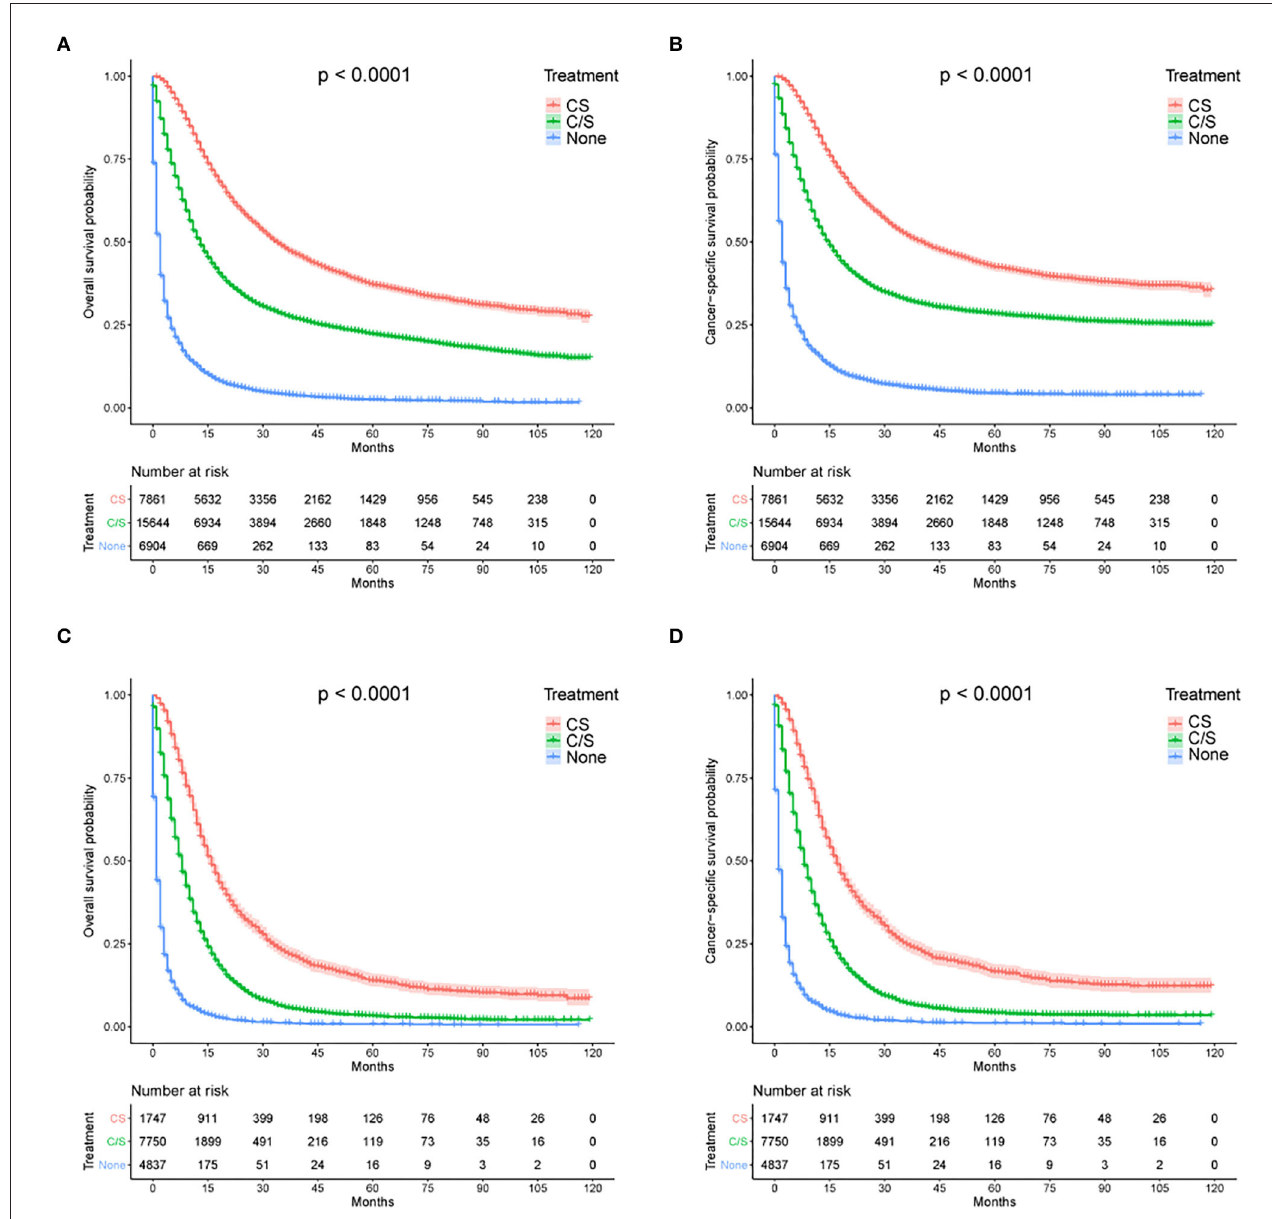
FIGURE 5 | Survival analysis of treatment options for (A) OS and (B) CSS among all patients with GAC; Survival analysis of treatment options for (C) OS and (D) CSS among AJCC stage IV tumor patients. CS, chemotherapy combined with surgery; C/S, chemotherapy or surgery alone; None, no chemotherapy or